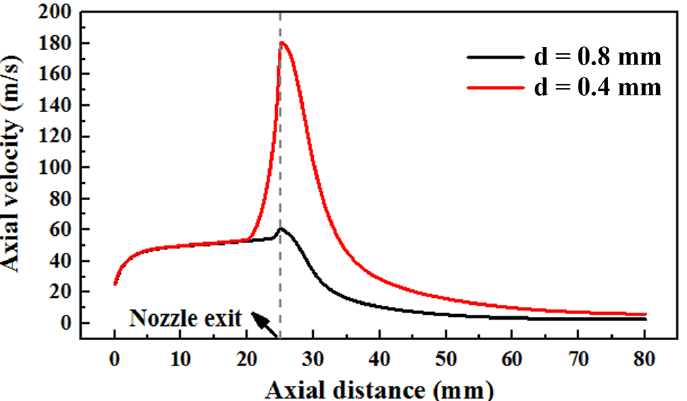
Figure 8. Axial velocity profiles of the two combustors with different nozzle exit diameters at V f = 25 m/s.